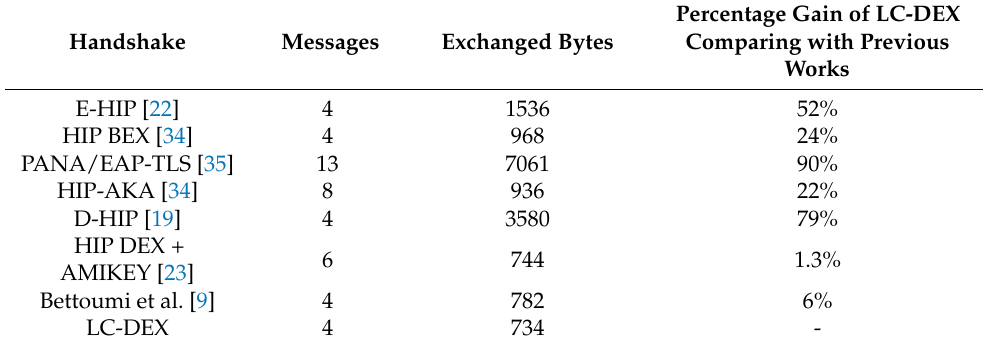
Table 6. Comparison of handshake packets’ sizes with other